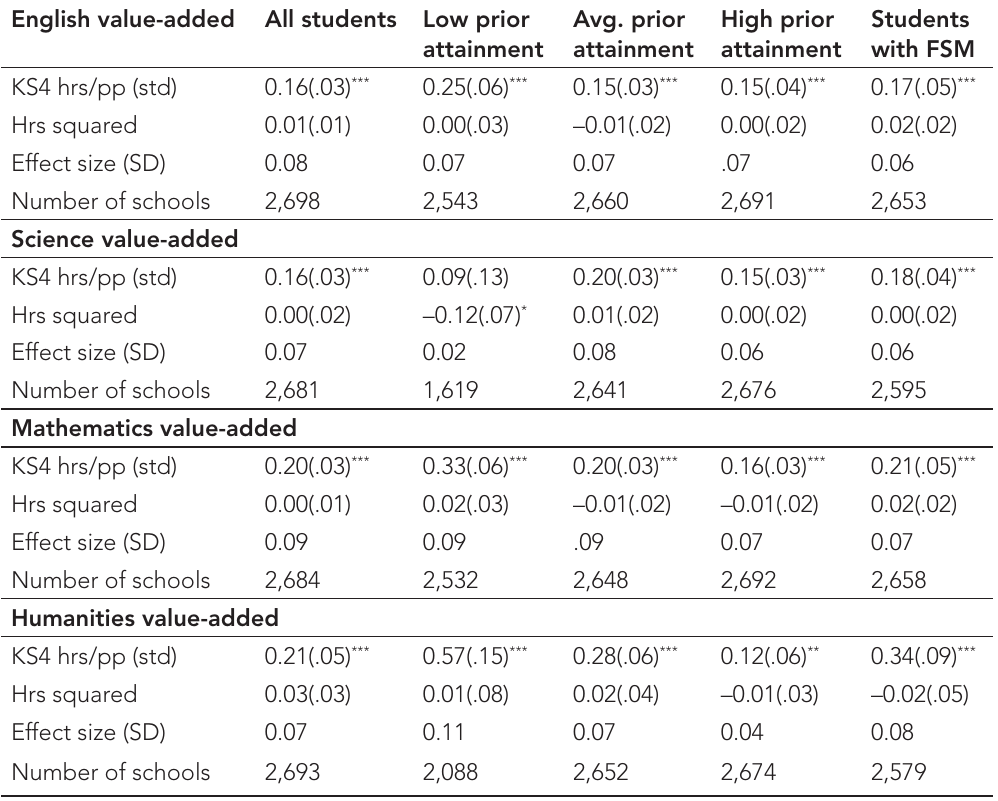
Table 2: Regression results for value added by sub-group and KS4 hours (2010–14) English value-added